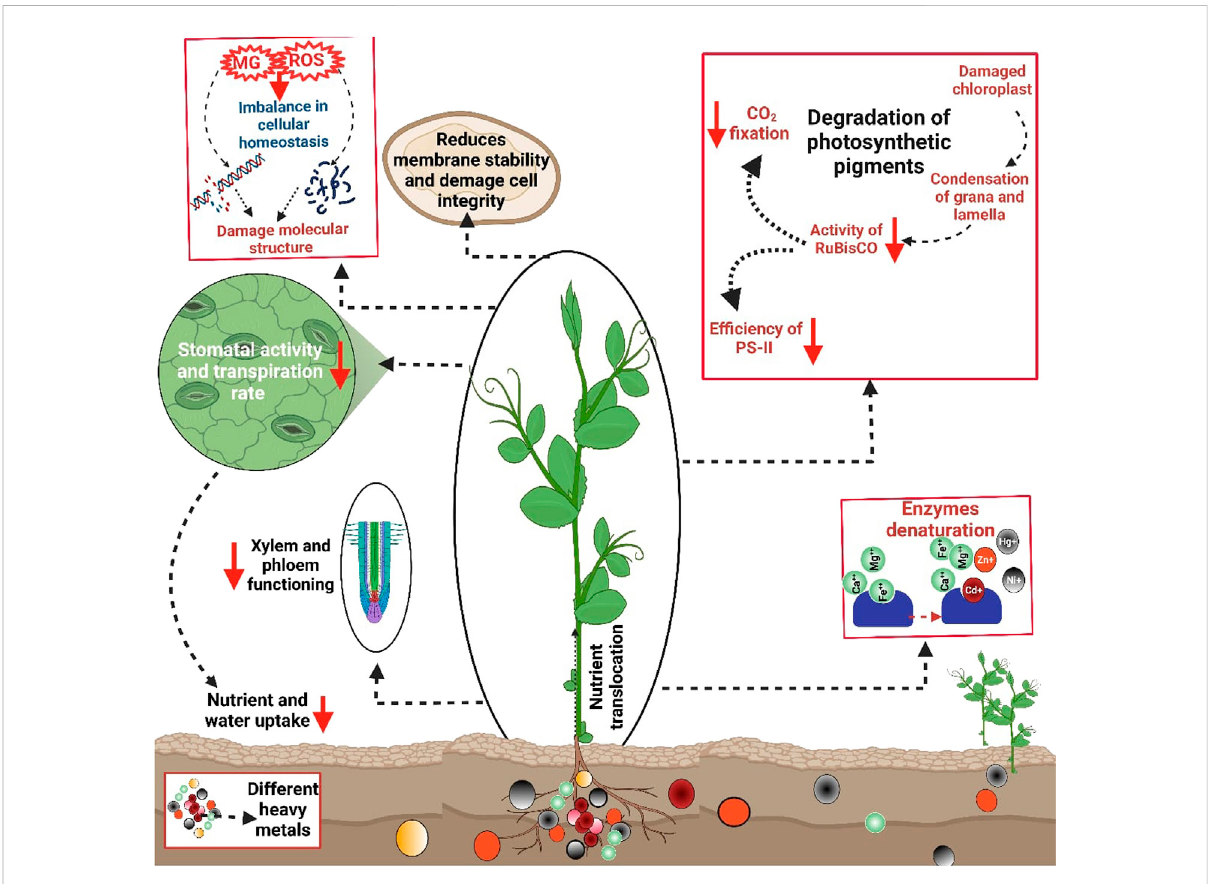
FIGURE 1 Effect of HMs toxicity on plants. The metals toxicity disturbs plant water relations, membrane stability, reduced nutrient water uptake, stomata functioning, xylem and phloem functioning, CO 2 fi xation, ef fi ciency of PS II, RuBisCO activities, damage chloroplast, and condense grana and lamella, thereby causing signi fi cant reduction in growth and